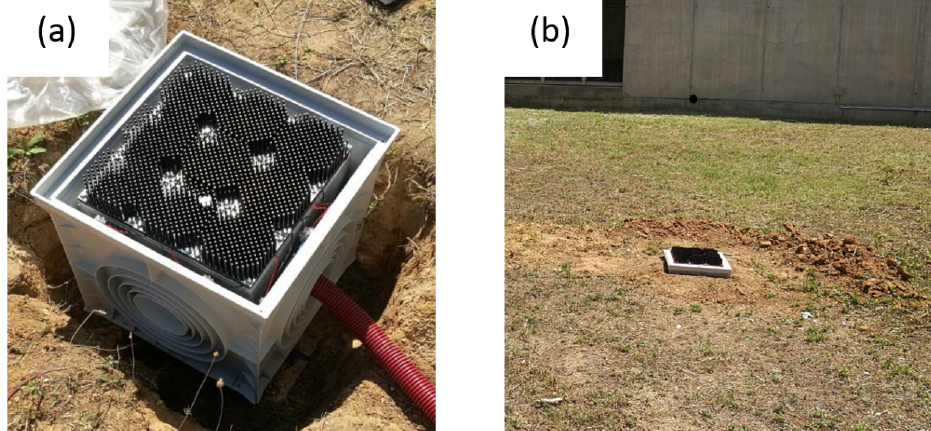
Figure 3. ( a ) View of the STEG before being buried (dimensions of the outer PVC catch basin 440 × 440 mm 2 cross sectional area and 400 mm length; of the inner aluminum block 300 × 300 mm 2